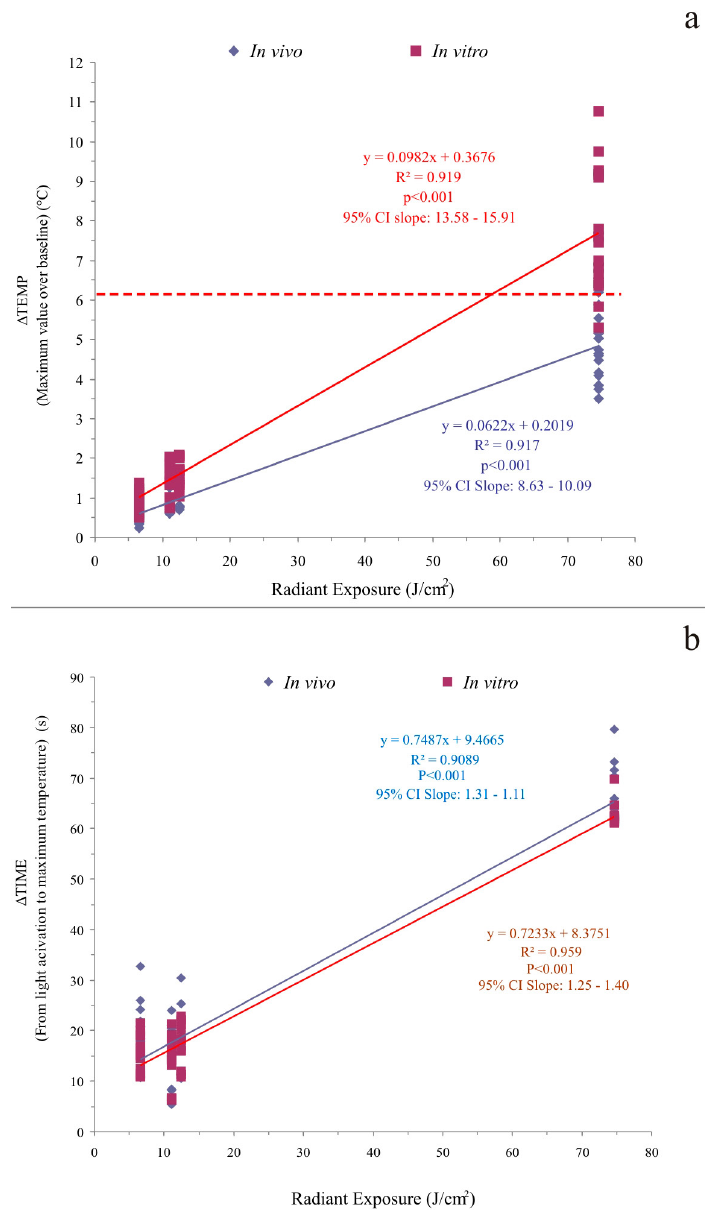
Figure 2- Regression analysis plot of in vivo and in vitro (a) ΔTEMP above pre-exposure, baseline temperature (˚C) within the pulp chamber vs. applied radiant radiant exposure, and (b) ΔTIME